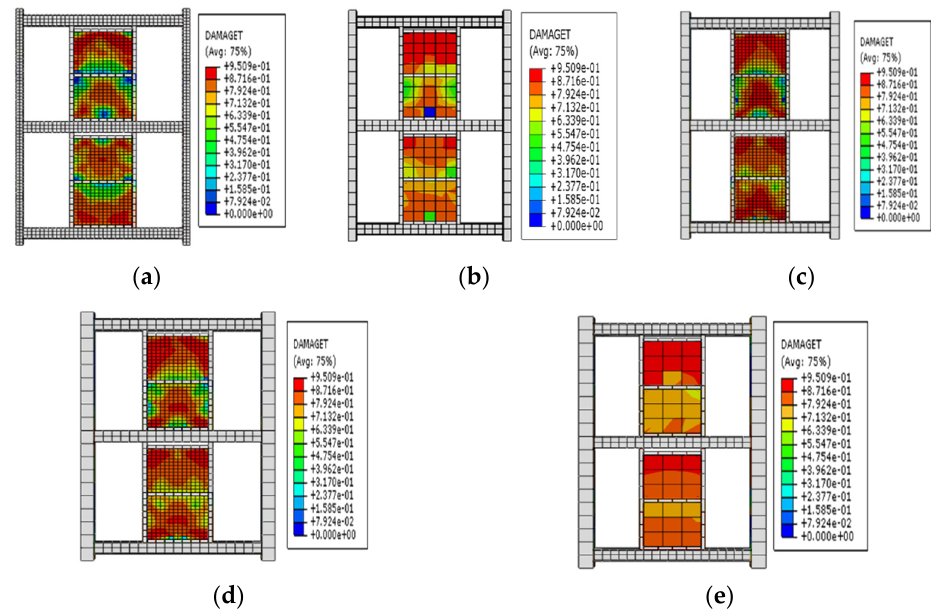
Figure 18. Stress contour plots of the EDCWs. ( a ) F11; ( b ) F12; ( c ) F13; ( d ) F14; and ( e ) F15.